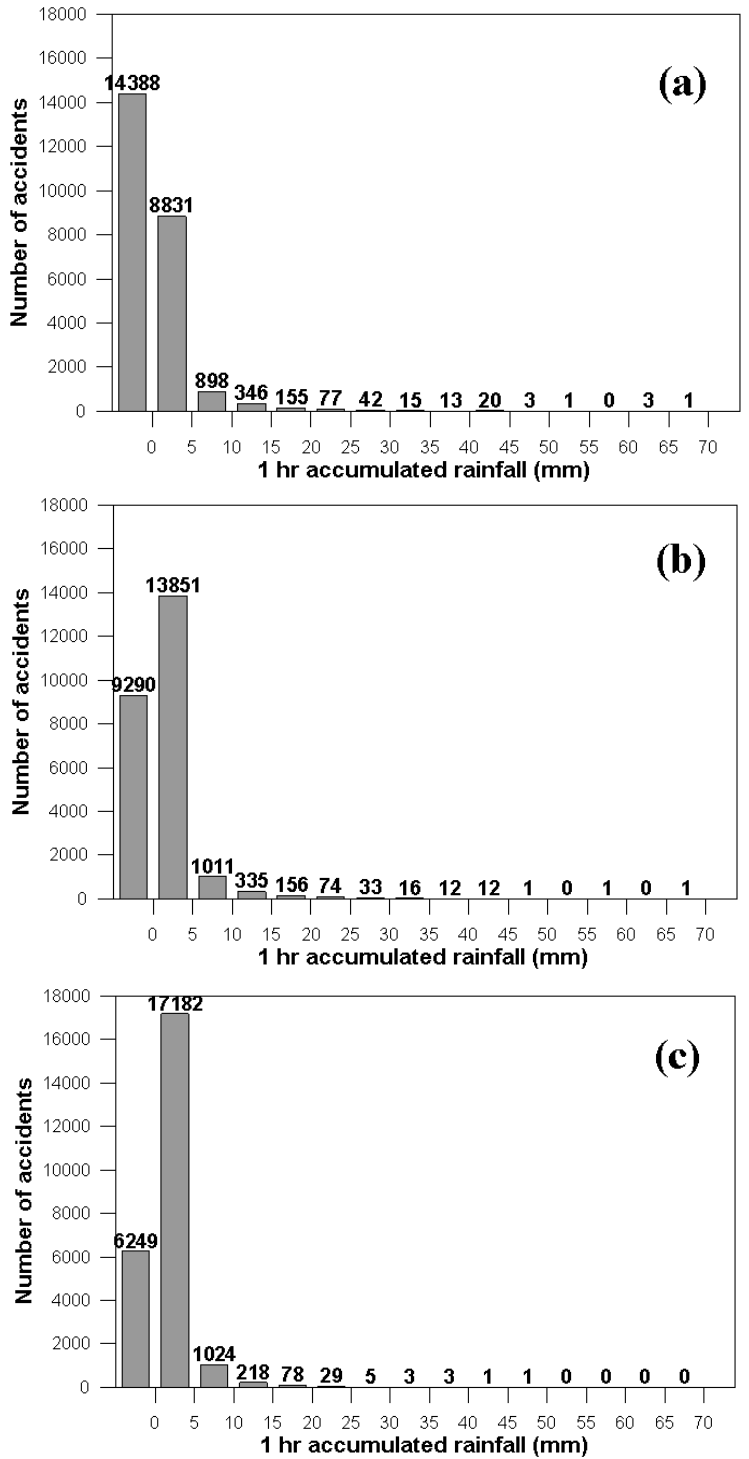
Figure 3. Number of accidents during 1 h accumulated rainfall measured by ( a ) rain gauges nearest to the accident location, ( b ) distributed rain gauges, and ( c ) radar.